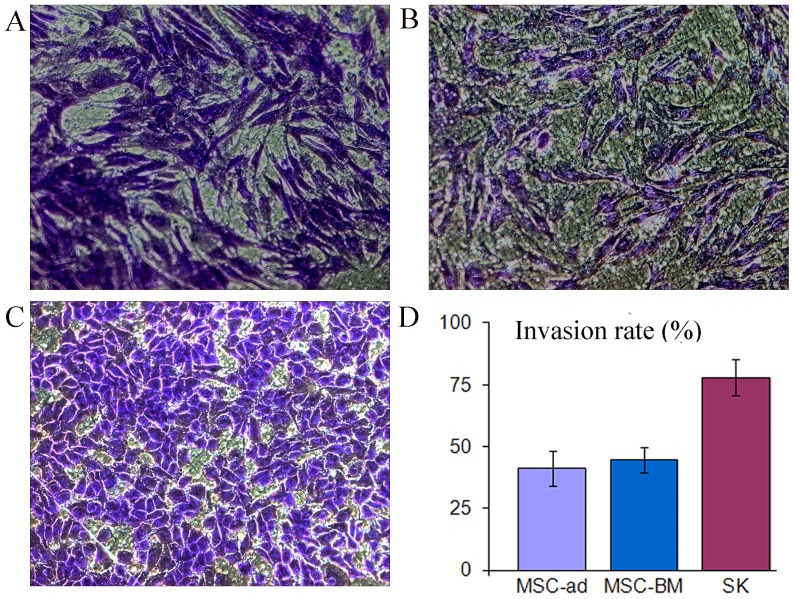
In vitro invasion assay A–C, the invasion of stained adipose-derived msenchymal stem cells (A), bone marrow-derived mesenchymal stem cells (B), and SK cells (C), were evaluated from transwells at 24 hours after culturing under low serum. D, based on the standard curve, the number of invading cells was quantitated. Magnifications: 100× (A–D).